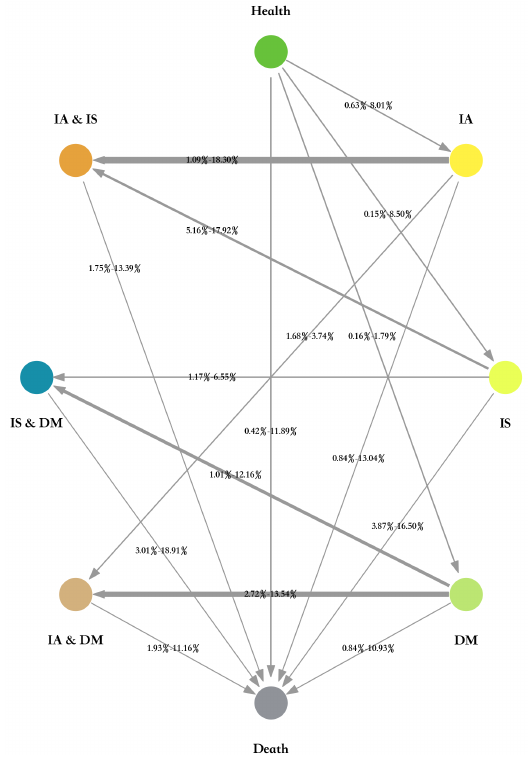
Figure 3. Transition probability graph of 5-year interval group.